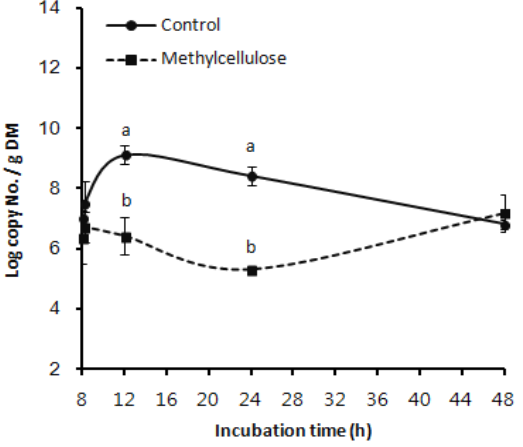
Figure 3. Detachment of Ruminococcus flavefaciens on rice straw as influenced by MC addition after 8 h of incubation. a,b Means with different letters differ significantly